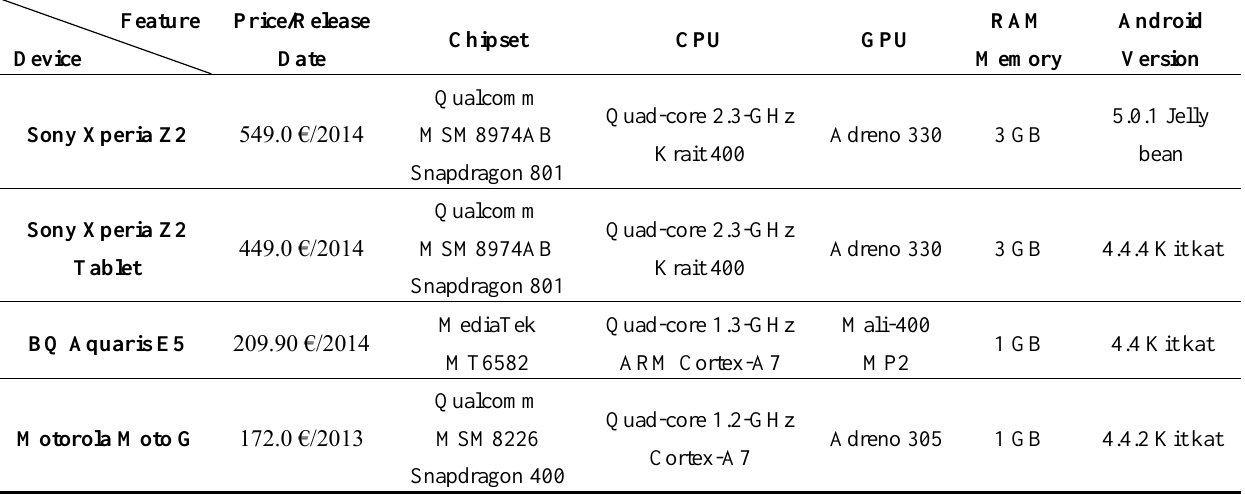
Table 2. Main relevant features of the 4 devices used for evaluating the computational efficiency of the vitisFlower